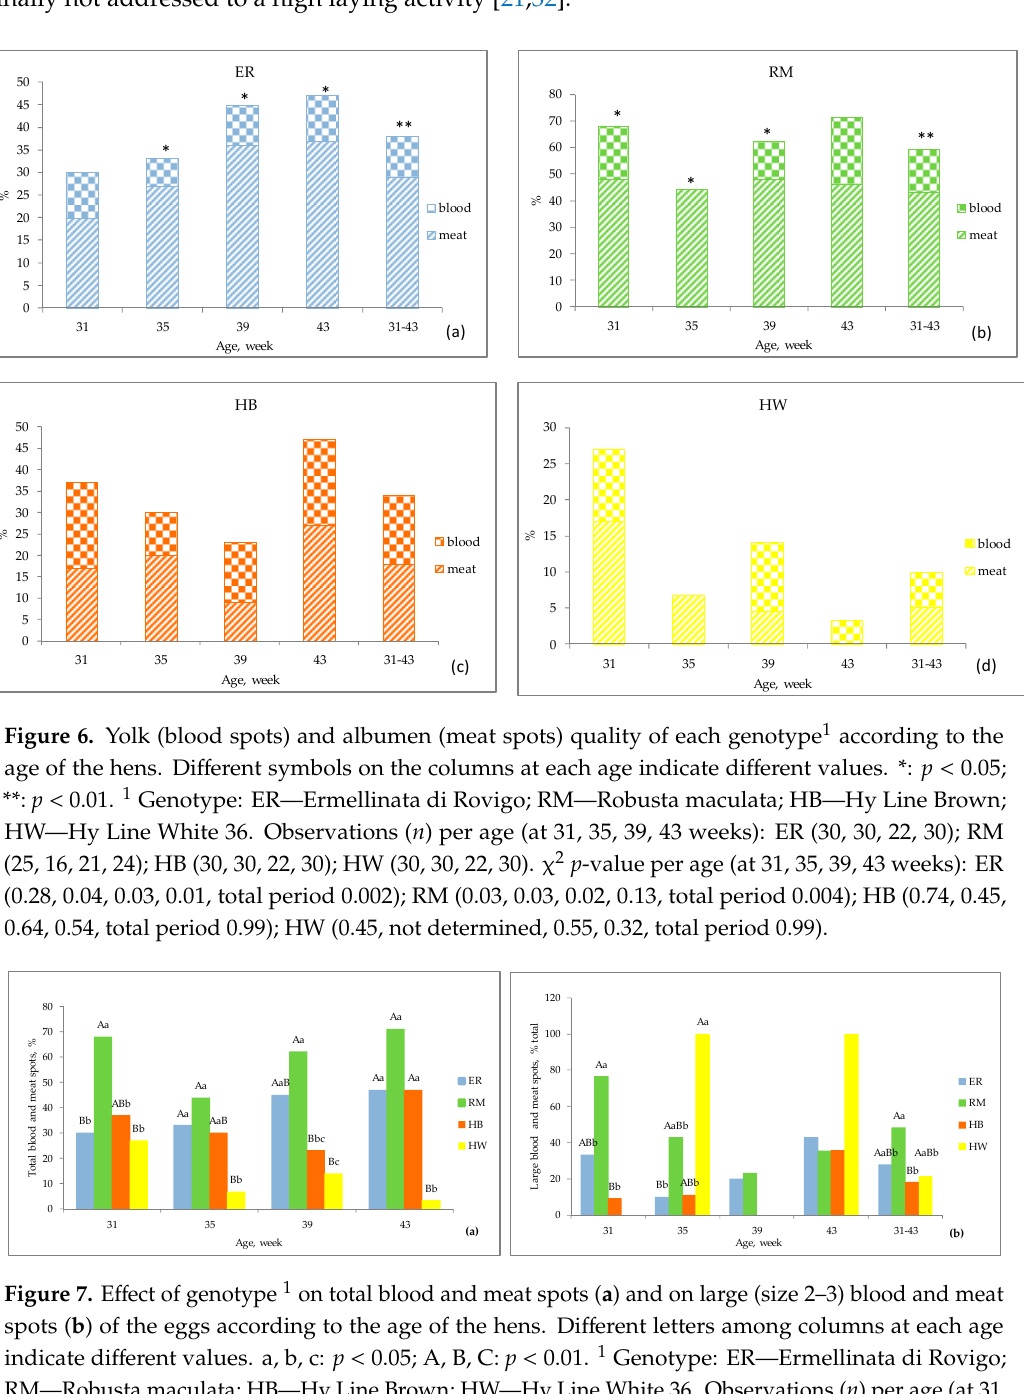
Figure 7 . Effect of genotype 1 on total blood and meat spots (a) and on large (size 2-3) blood and meat spots (b) of the eggs according to the age of the hens. Different letters among columns at each age indicate different values. a, b, c: p < 0.05; A, B, C: p < 0.01. 1 Genotype: ER - Ermellinata di Rovigo; RM - Robusta maculata; HB - Hy Line Brown; HW - Hy Line White 36. Observations ( n ) per age (at 31, 35, 39, 43 weeks): ER (30, 30, 22, 30); RM (25, 16, 21, 24); HB (30, 30, 22, 30); HW (30, 30, 22, 30). χ 2 p -value per age (at 31, 35, 39, 43 weeks): total blood and meat spots (0.008, 0.02, 0.004, < 0.0001); meat and blood spots (size 2-3) (0.0002, 0.03, 0.55, 0.08, total period 0.01).